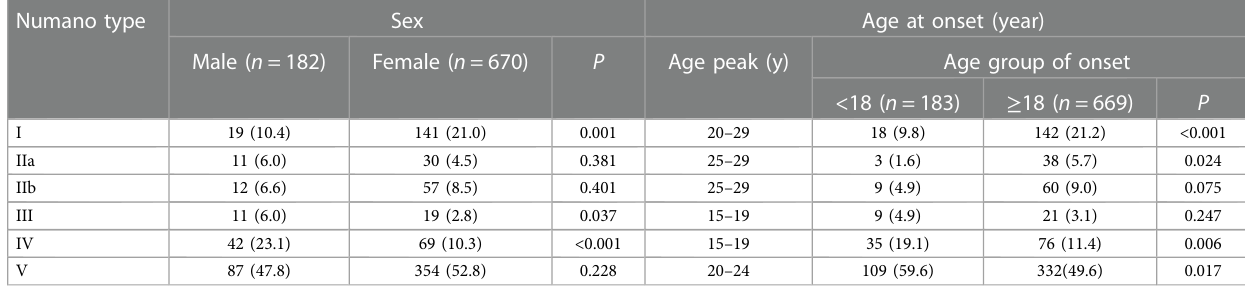
TABLE 2 Sex and age at onset among the different angiographic classi fi cations in TAK patients [ n